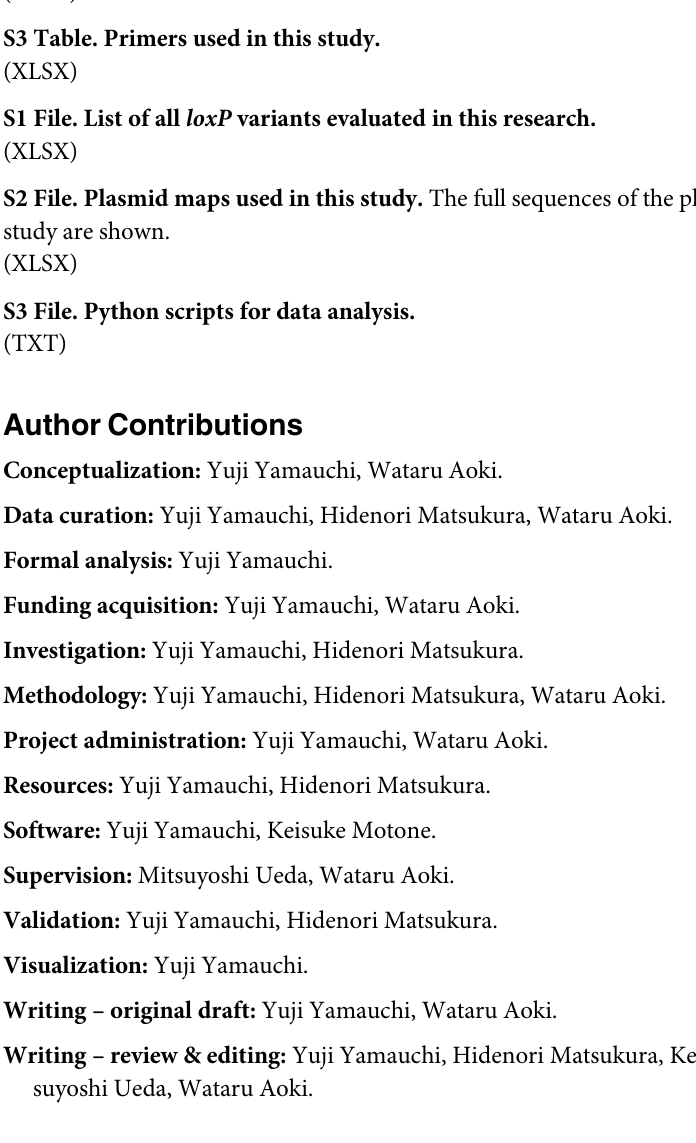
S1 Table. Sequences of loxP variants confirmed by Sanger sequencing. S2 Table. List of loxP variants measured by qPCR. S3 Table. Primers used in this